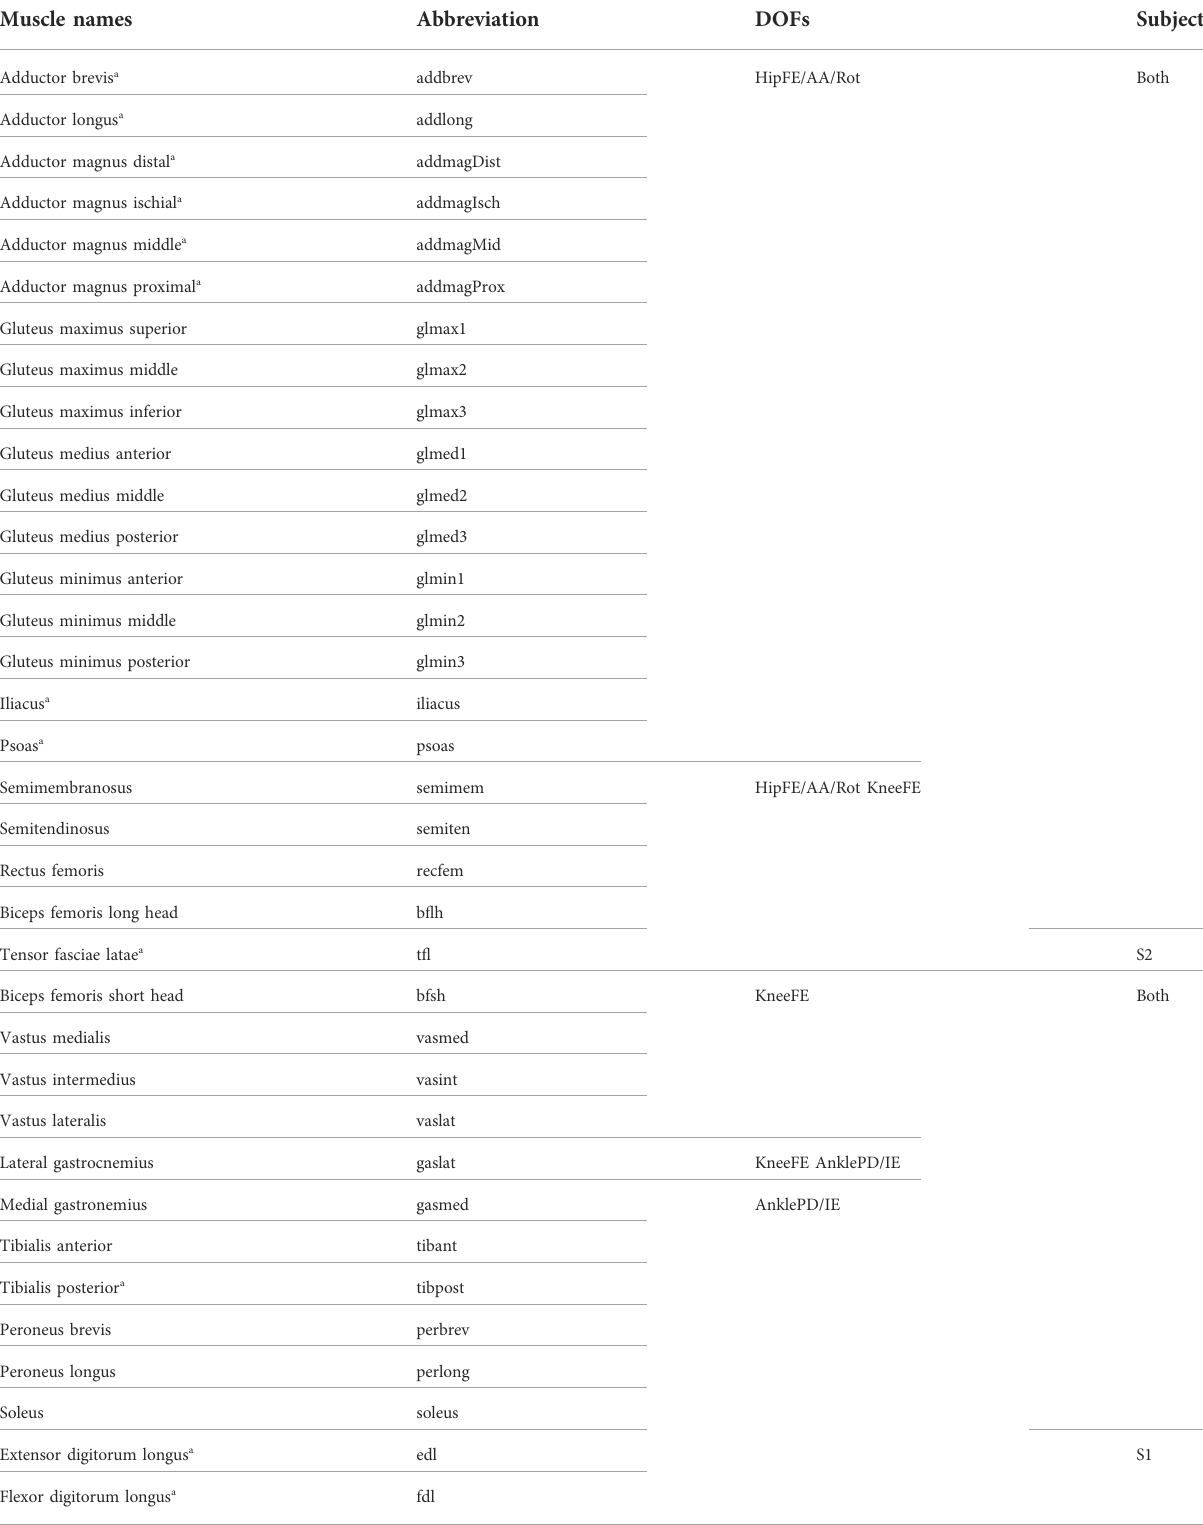
TABLE 1 List of muscles in the model for each subject and which DOF each muscle